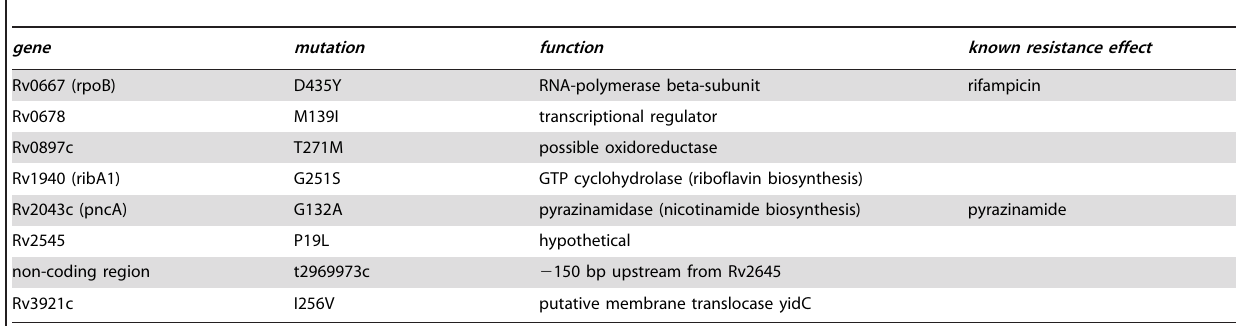
This table excludes synonymous mutations in coding regions, and mutations in PPE/PGRS genes or repetitive sequences. Mutations in coding regions are numbered as amino acids substitution (upper case). Numbering of base substitutions (lower case) in non-coding regions is given relative to the H37Rv